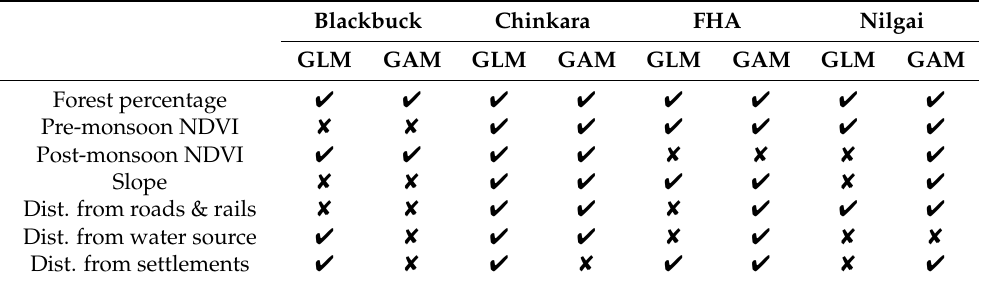
Table A1. Variables found significant ( (cid:52) ) and not significant ( (cid:56) ) for habitat suitability modeling of the four focal antelope species.